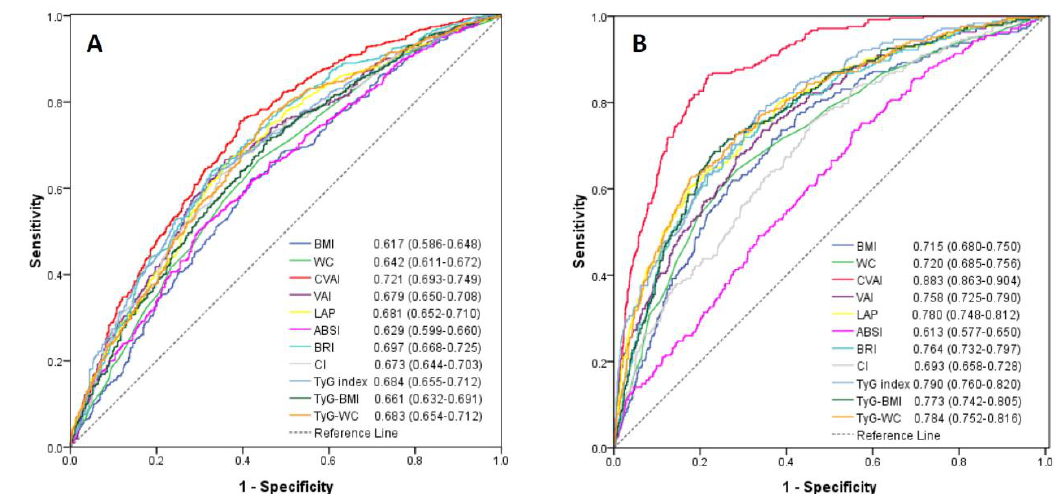
Figure 2. Receiver-operating characteristic curves of anthropometric and cardiometabolic indices for estimating 10-year ASCVD risk ≥7.5% in men ( A ) and women ( B ). There was significant difference of the area under curve for each anthropometric and cardiometabolic index (all p -value <0.05) when compared with CVAI using the DeLong method.